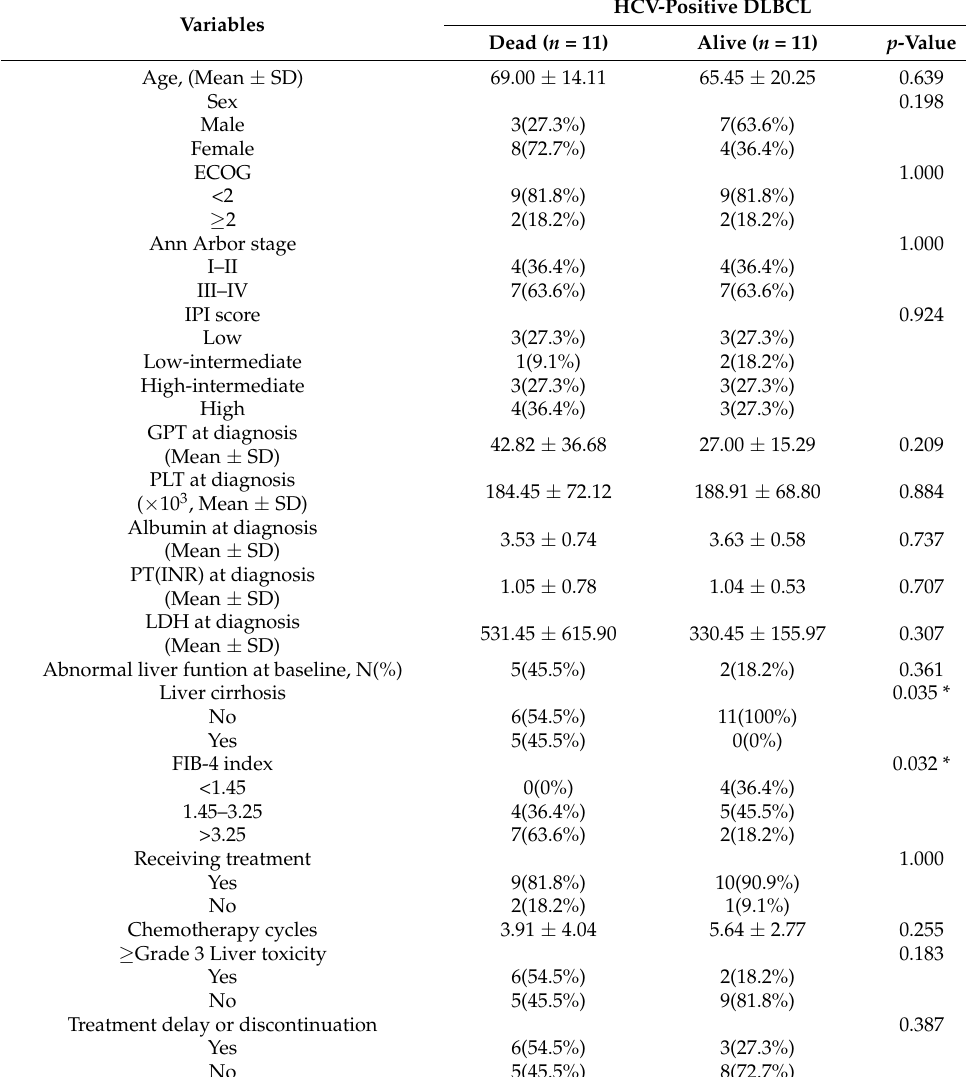
Table 5. Different variables in the dead and alive groups of HCV-positive DLBCL